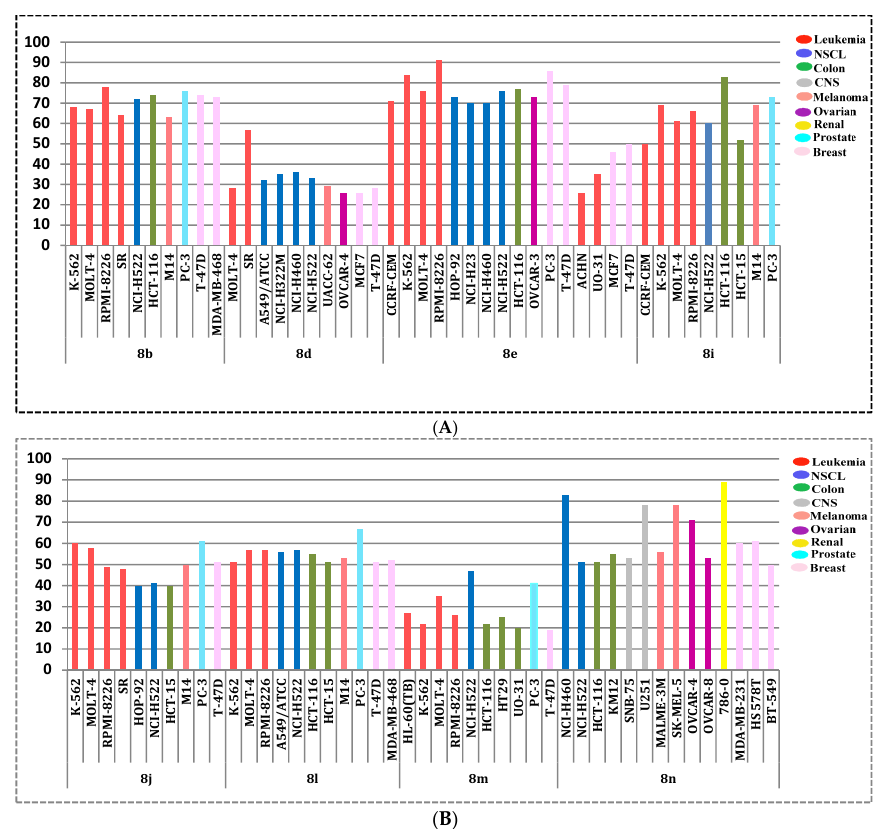
Figure 4. ( A ) The most sensitive cell lines towards the target pyridines 8b , 8d , 8e and 8i according to the GI%; ( B ) the most sensitive cell lines towards the target pyridines 8j , 8l , 8m and 8n according to the GI%. The cytotoxic activity of compounds 8b and 8e were evaluated against non ‐ tumorigenic human lung fibroblast WI ‐ 38 cell line utilizing the MTT colorimetric assay developed by T. Mosmann [26] (Table 3). Interestingly, both the tested compounds 8b and 8e displayed non ‐ significant weak cytotoxic activity towards WI ‐ 38 cell line with IC 50 values of 91.5 ± 4.53 and 83.14 ± 5.21 μ M, respectively.